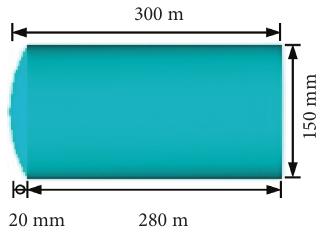
Figure 2: Projectile size.